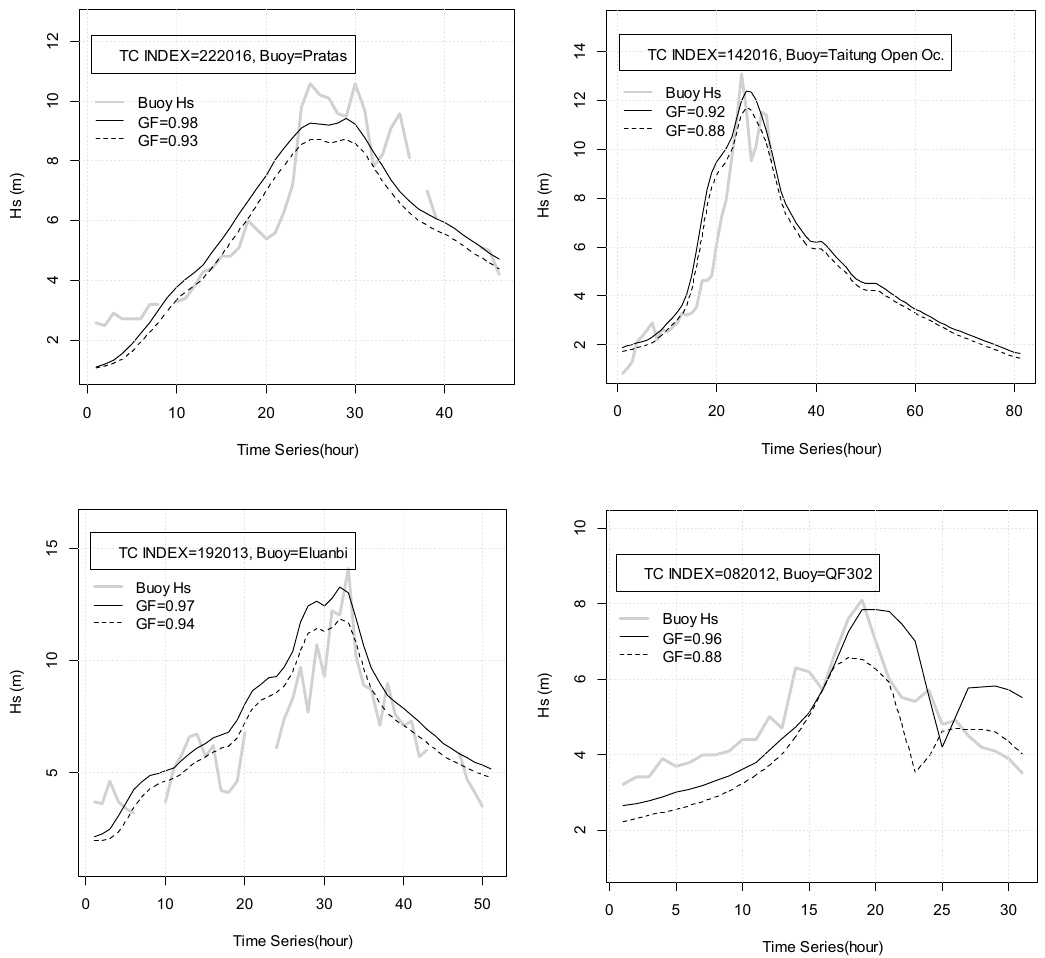
Figure 5. Influence of gust factors on the simulated wave height series. GF: gust factor.